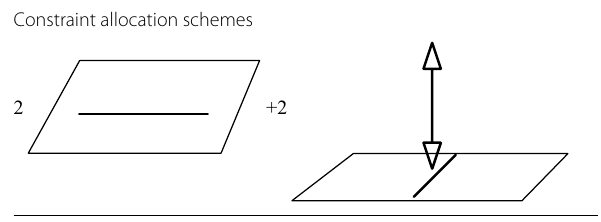
Table 2 Constraint allocation schemes Constraint allocation schemes